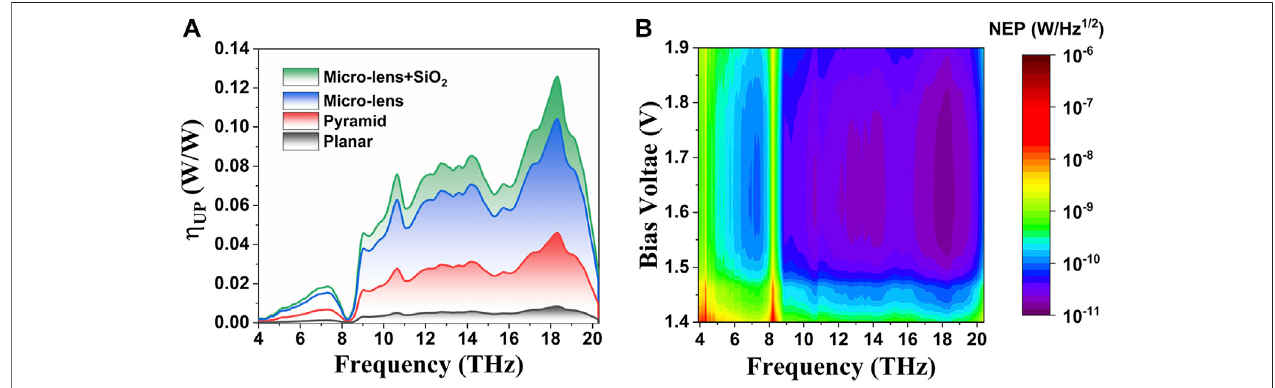
FIGURE 6 | (A) The calculated upconversion ef fi ciencies for the devices with planar structure, micro-pyramid, micro-lens, and micro-lens combined with AR coating. (B) The calculated NEP under different bias voltages at 3.5 K for the upconversion imaging system with the optimal micro-lens structure and SiO 2 AR coating.